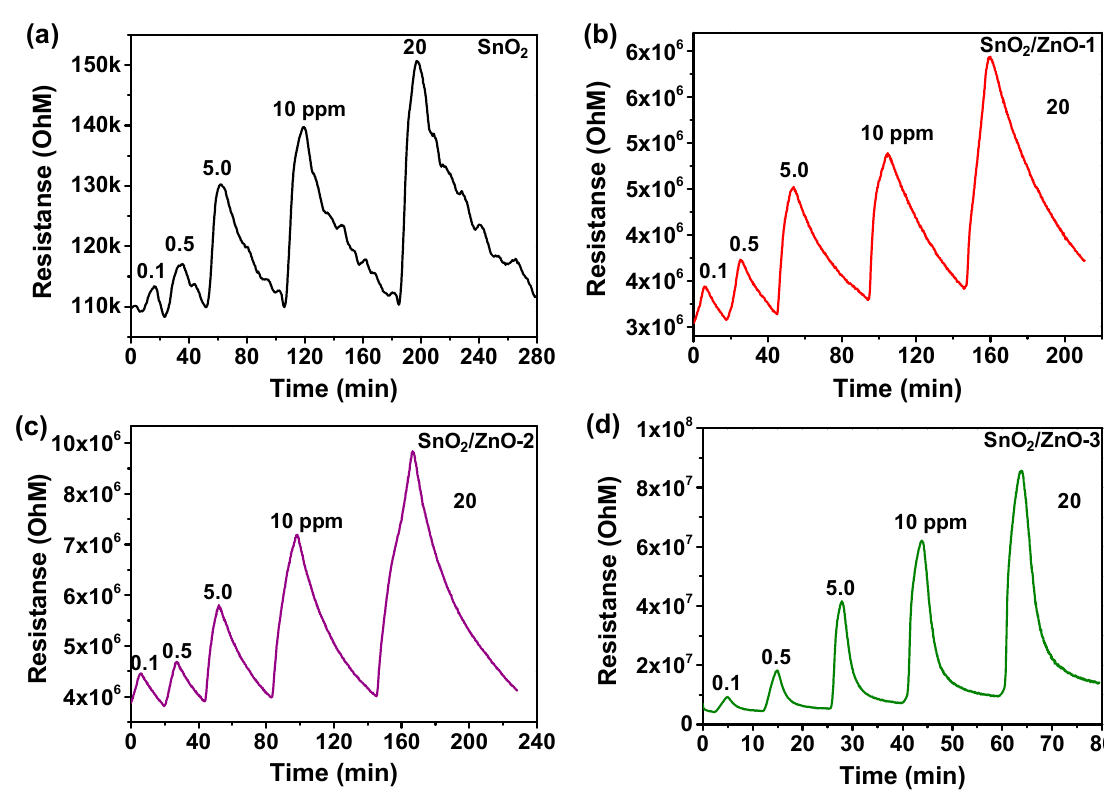
Figure 5. Dynamic responses of ( a ) pristine SnO 2 , ( b ) SnO 2 /ZnO-1, ( c ) SnO 2 /ZnO-2, ( d ) SnO 2 /ZnO-3 nanofibers to different concentrations of NO 2 gas (0.1, 0.5, 5, 10, 20 ppm) at room temperature.